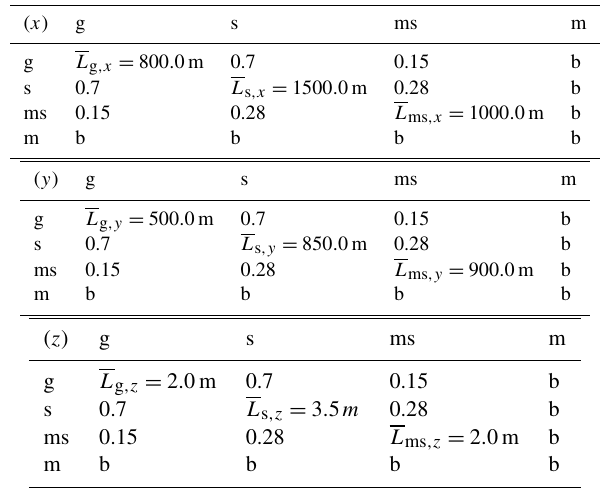
Table 2. Mean length (diagonal values) of each category (g: gravel; s: sand; ms: muddy sand; m: mud) and embedded transition proba- bility (non-diagonal values) in the longitudinal ( x ), horizontal trans- verse ( y ), and vertical transverse ( z ) directions. Matrices read as transition probabilities from the row facies to the column facies. The background category is designated by the letter